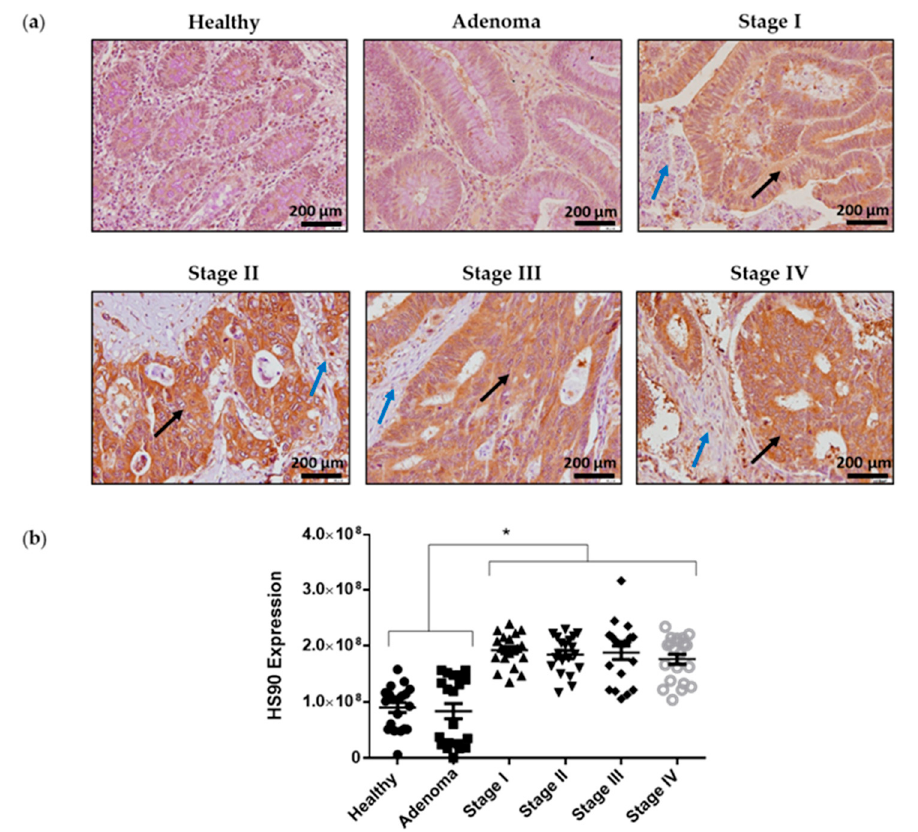
Figure 9. Hsp90 expression levels in colorectal cancer human samples: ( a ) Representative images of Hsp90 immunoreactivity in normal colonic mucosa, adenoma and colorectal cancer (TNM stages I–IV). Images were obtained with 20× objective. Scale bar 125 µm. ( b ) Statistical quantification of Hsp90 staining intensity in epithelial cancer cells at different colon cancer stages and in adenoma and normal colon tissue. A total of 30 human colon samples were analysed including: different TNM stages (I–IV) from colon adenocarcinomas, colon adenoma compared to human colon healthy tissues (normal colonic mucosa, n = 5; adenoma, n = 5; colorectal cancer, n = 5 of all stages) Scale bar, 200 µm. Black arrows show tumoral tissue and blue arrows show stromal tissue. Five photographs of each tissue were quantified and data are represented as scatter plot. Results are represented as Mean ± SEM for signal intensity scoring per area. Analysis was performed by employing Kruskal-Wallis with Tukey correction test (* p <